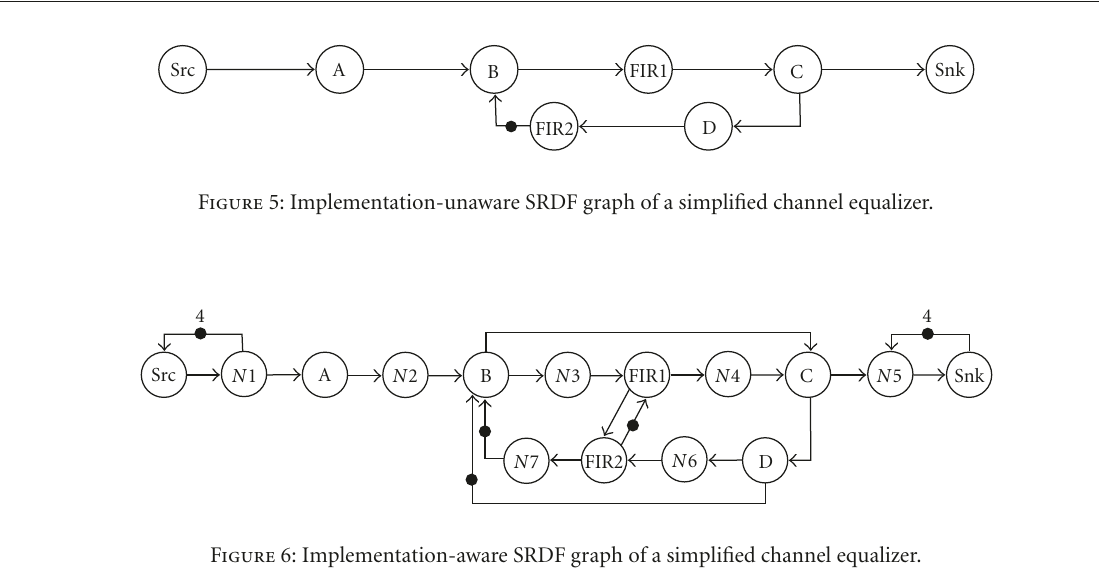
Figure 6: Implementation-aware SRDF graph of a simplified channel equalizer.